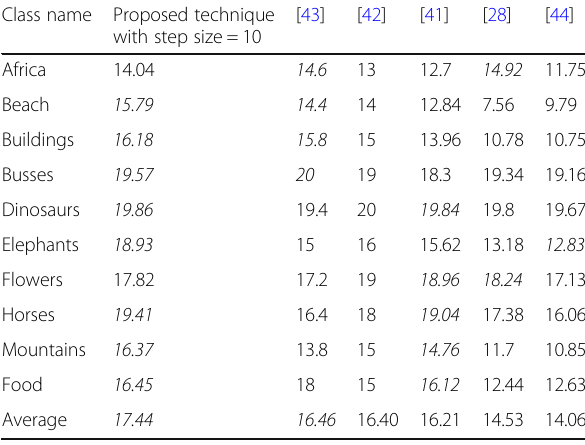
Table 3 Average-recall performance comparison of the proposed technique with recent CBIR techniques on the image benchmark of the